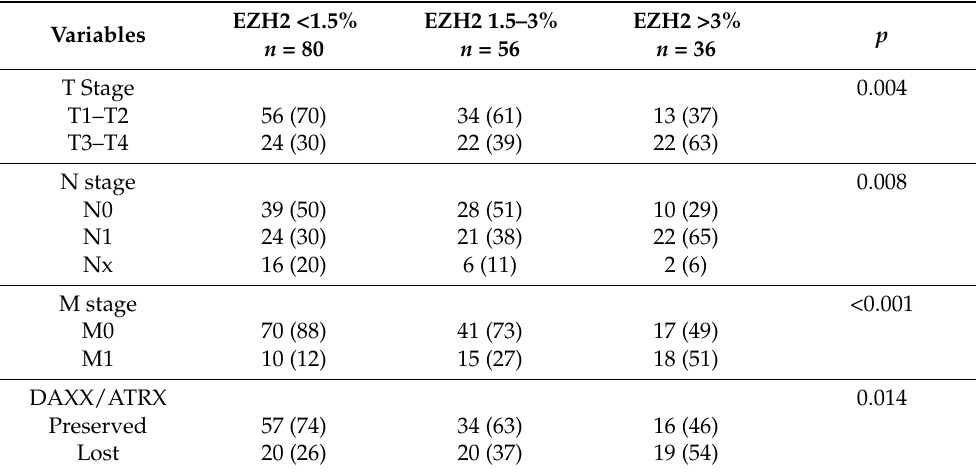
Table 3. Correlation between EZH2 expression and clinico-pathological features.